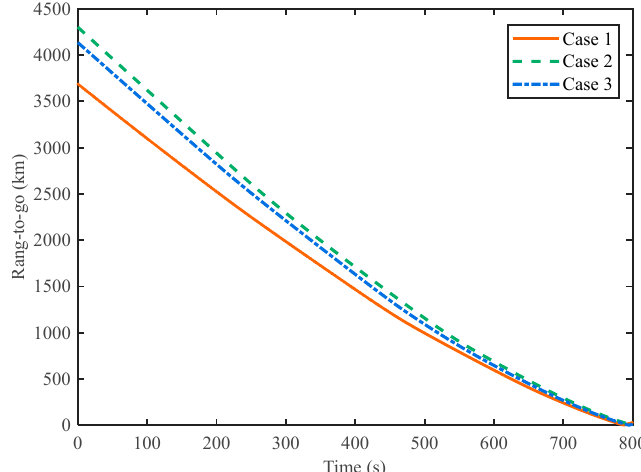
Figure 16. Time histories of the velocity.